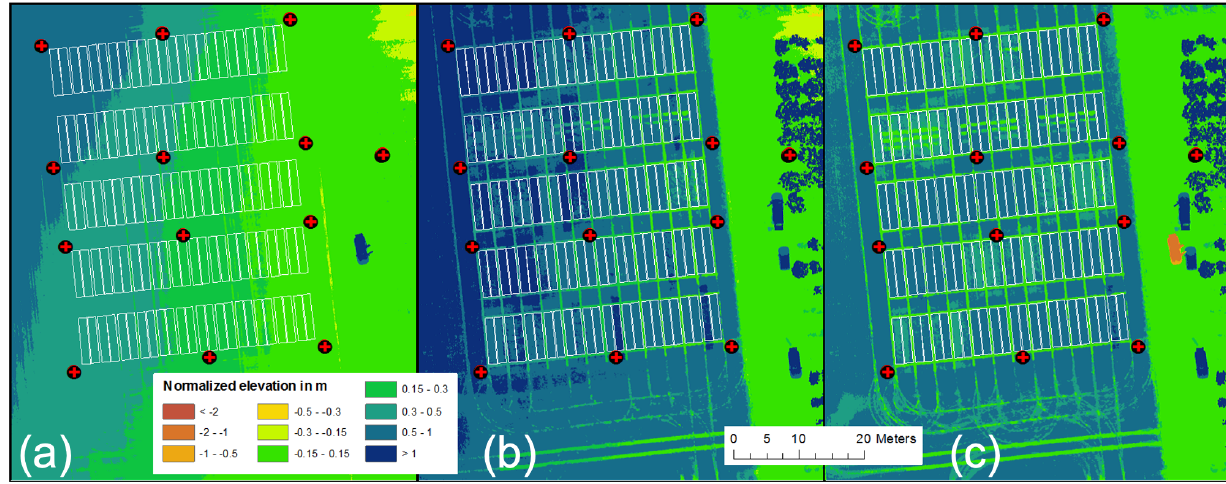
Figure 4. Visualization of ( a ) the normalized base Digital Surface Model (DSM) at the beginning of the growing season 2020 on 26 March. In the middle, ( b ) represents a normalized Crop Surface Model (CSM) for 12 June, and ( c ) is the CH computed by subtracting ( a ) from ( b ).